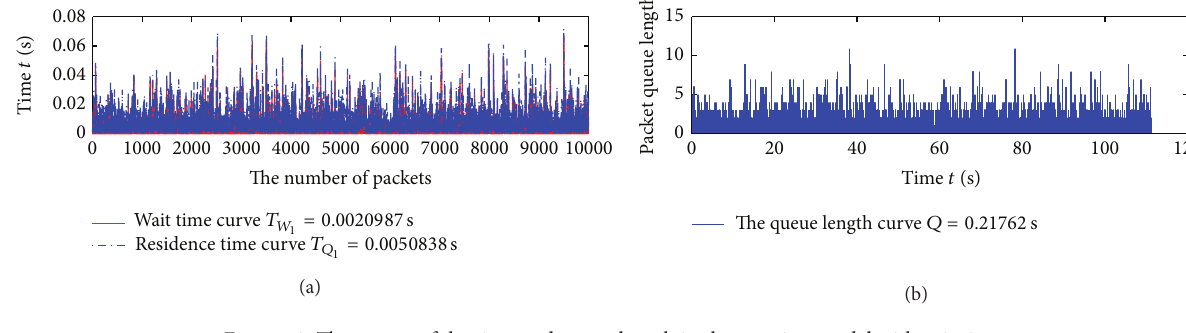
Figure 8: The curves of the time and queue length in the queuing model with